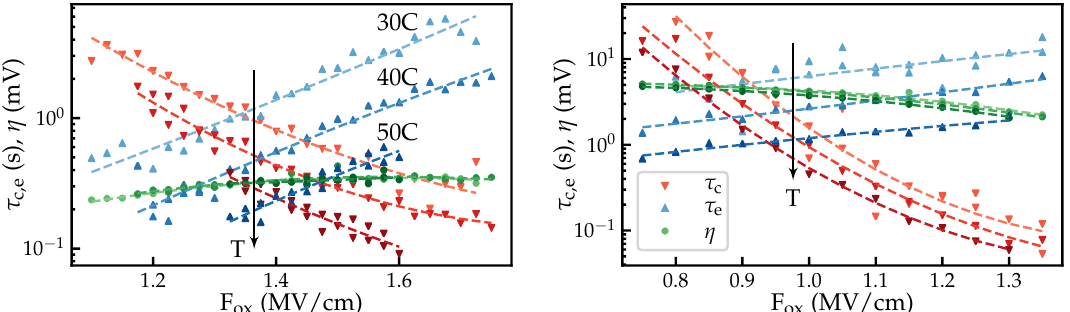
Figure 6. Two defects characterized in detail. From the intersection points and the steepness of the charge capture and emission times, the positions and the trap levels of the defects can be